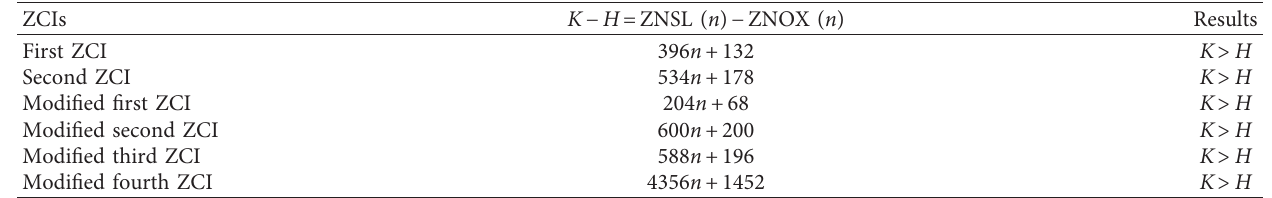
Table 17: Comparison of indicated ZCIs for all n .